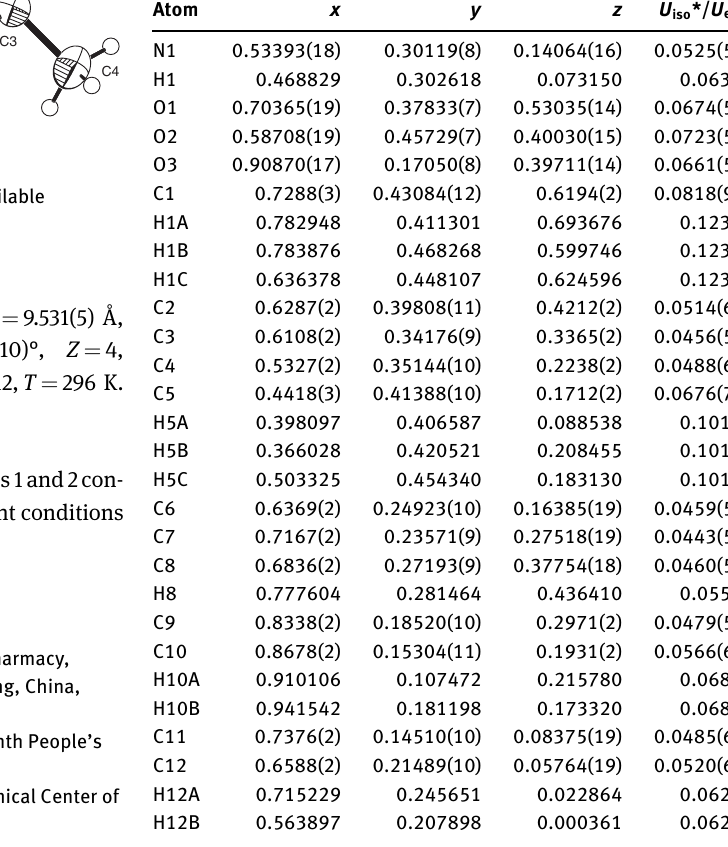
Table 2: Fractional atomic coordinates and isotropic or equivalent isotropic displacement parameters (Å 2